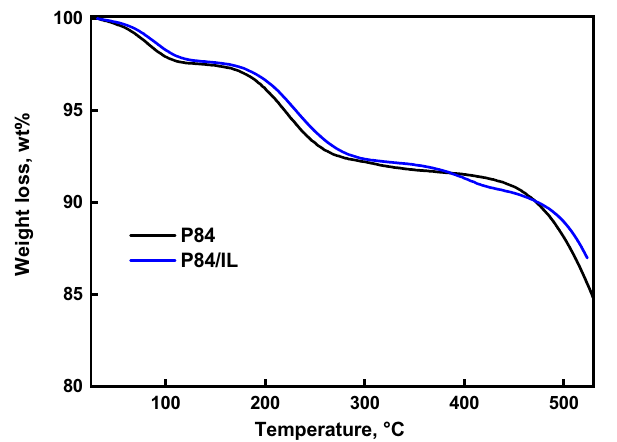
Figure 5. TG curves of the P84 and P84/IL membranes.